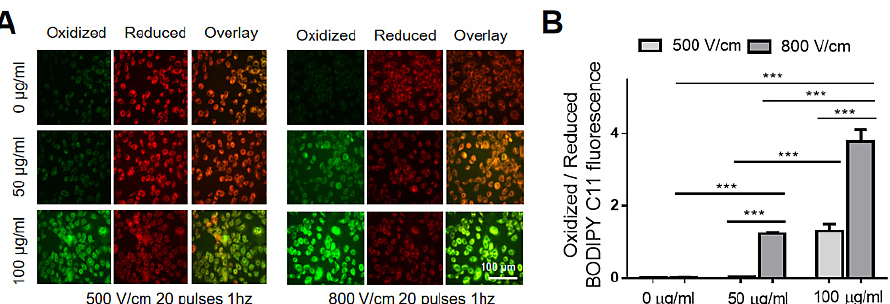
Figure 4. Enhanced cellular lipid peroxidation after IRE treatments (500 V/cm or 800 V/cm, 20 plus, 1 Hz) with different amounts of Au-MSNs. ( A ) Fluorescent microscopic images of EMT-6 cells after IRE treatment with Au-MSNs. Cellular lipid peroxidation was evaluated using a BODIPY™ 581/591 C11 (lipid peroxidation sensor) dye. Microscopic images show that oxidized form of lipid (green) increased by combination treatment. ( B ) Extent of lipid peroxidation. The observed relative fluorescence intensity (green/red) shows that combination treatment of IRE (800 V/cm) and An-MSNs (100 µ g/mL) induced highest extent of lipid oxidation. Data are provided as means ± standard deviation. Data were tested for significance using two-way ANOVA. Significant differences are indicated by *** p < 0.01 ( n =